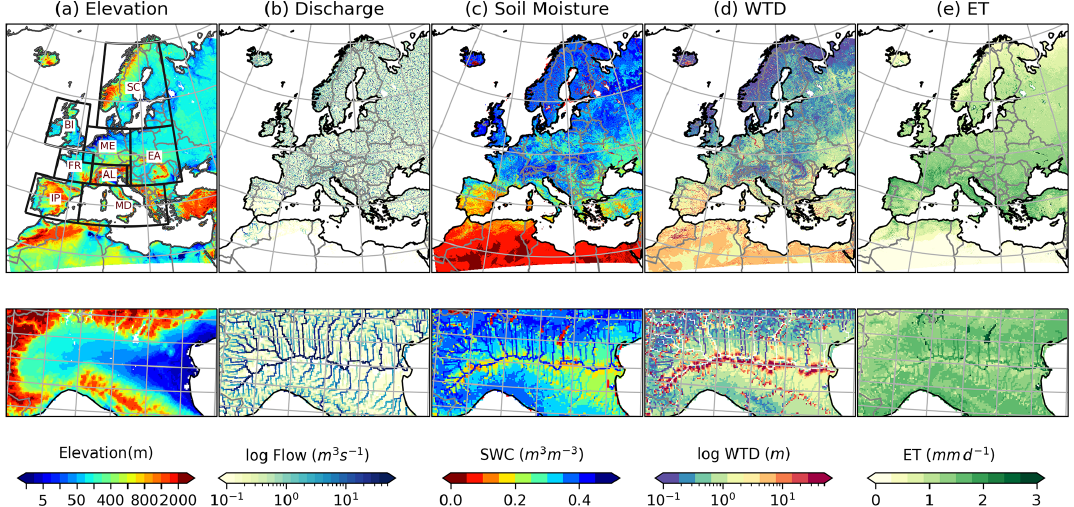
Figure 1. Maps of EURO-CORDEX domain at 3km resolution (1544 × 1592 grid cells) showing spatially averaged distribution of (a) elevation, (b) discharge, (c) surface soil moisture, (d) water table depth and (e) evapotranspiration (1997–2006), along with close-ups of the Po River basin in the Alpine (AL) region simulated by ParFlow-CLM model. Red color in (d) indicates deeper water table with maximum of 51m depth. The black boxes in (a) correspond to PRUDENCE regions, with their common abbreviations indicating names of the regions (FR: France; ME: mid-Europe; SC: Scandinavia; EA: eastern Europe; MD: Mediterranean; IP: Iberian Peninsula; BI: the British Isles; AL: